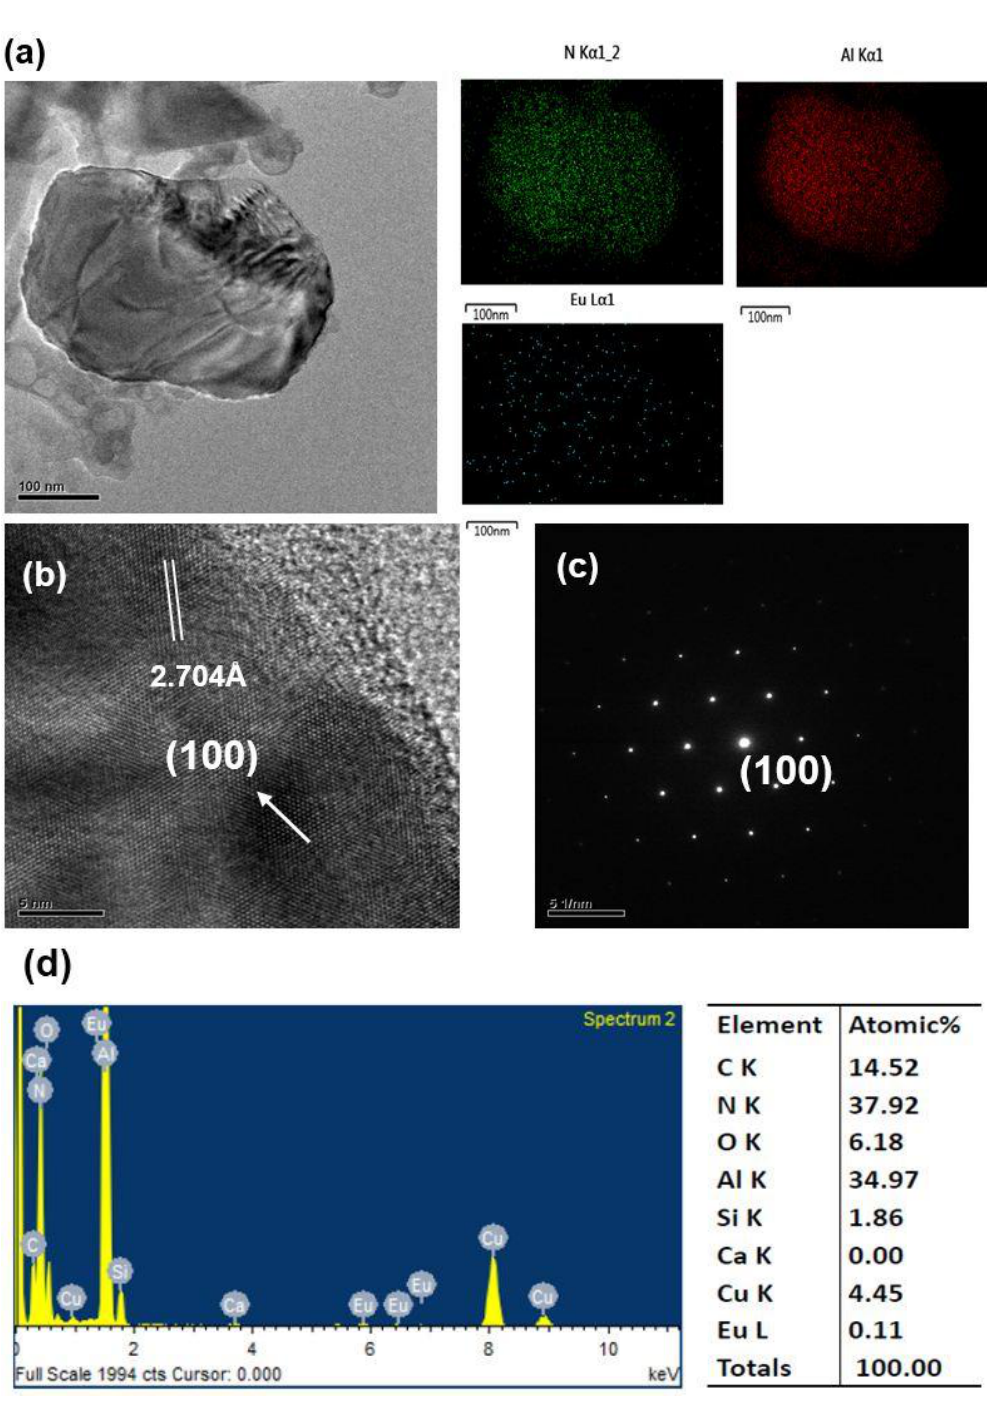
Figure 3. ( a ) TEM image and corresponding element mapping of Al, N, and Eu; ( b ) HRTEM image; ( c ) SAED pattern; and ( d ) element analysis of a plate-like particle (showing it to be AlN:Eu 2+ ) in a product synthesized with Ca:Al:Si:Si 3 N 4 :Eu 2 O 3 :NaN 3 :NH 4 Cl = 0.25:1.0:0.25:0.25:0.02:3.5:0.6.